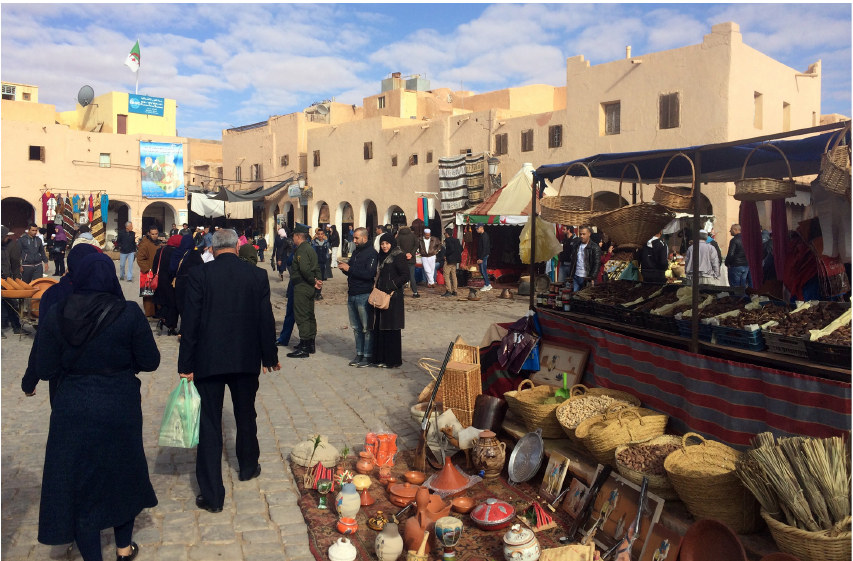
Fig. 8. The market for dates (palm fruits), Mozabit rugs and traditional